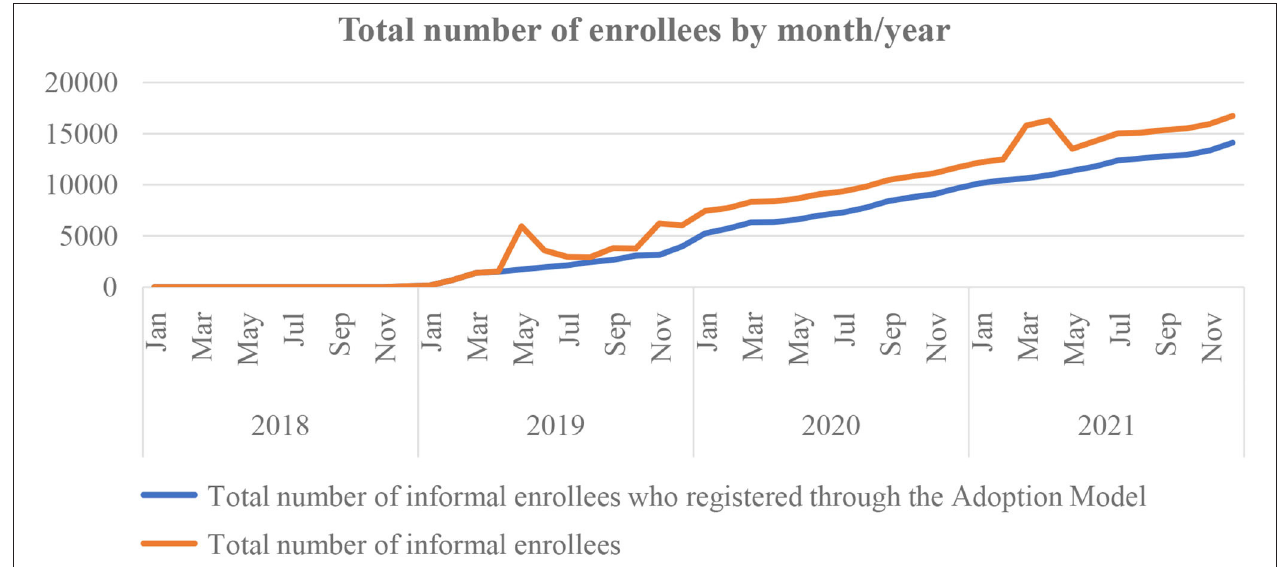
FIGURE 3 | Trend of health insurance coverage before and during the adoption model intervention among informal sector enrollees between the year 2018 and 2021 in Anambra State Health Insurance Scheme. about government programs usually marred by corrupt or